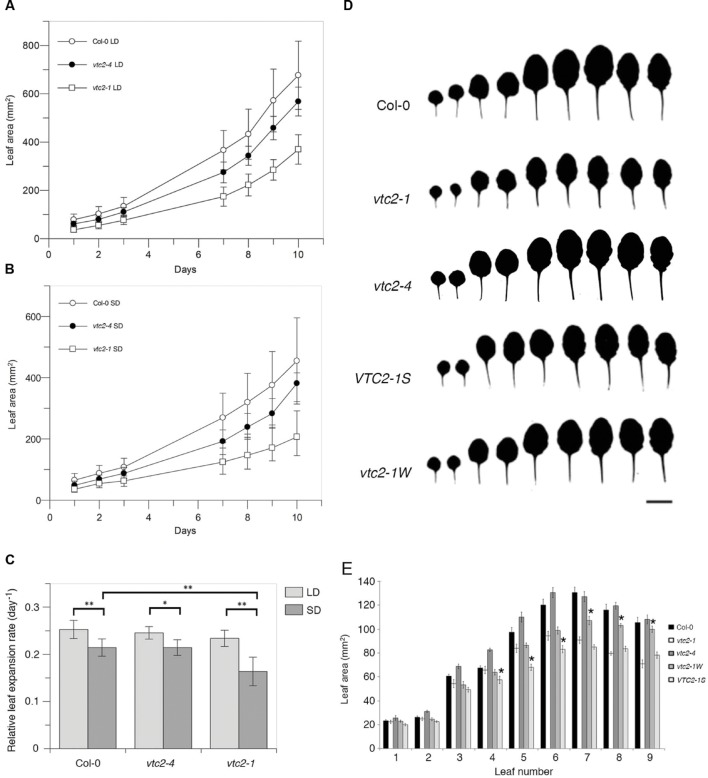
(A–C) Rosette and leaf area measurements of Arabidopsis thaliana vtc2 mutants.
(A) Surface area measurements (mm2) of leaves taken over a 10-day period under long-day (14 h) conditions. Values are mean and error bars indicate SD (n = 12). (B) Surface area measurements (mm2) of leaves taken over a 10-day period under short-day (8 h) conditions. Values are mean and error bars indicate SD (n = 12). (C) Relative leaf expansion rate (RLER, day-1) was calculated as the slope of a linear fit to a graph of natural log leaf area (mm) versus time (days). RLER was calculated from data in Figures 2A,B. Values are mean and error bars indicate SD (n = 10–12). Significant differences were determined with a one-way ANOVA and Tukey HSD post hoc test (∗p = 0.005, ∗∗p < 0.001). (D) Silhouettes of leaves from 6-week-old plants grown under short-day conditions. Scale bar = 1 cm. (E) Surface area measurements (mm2) of leaves taken from 6-week-old plants grown under short-day conditions. Values are mean and error bars indicate SD (n = 7–10). Differences between leaf areas of vtc2-1, vtc2-1W and VTC2-1S were assessed using a Student’s t-test (∗p < 0.05).